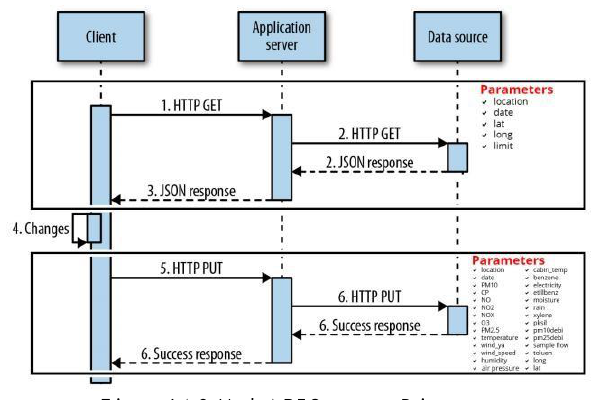
Figure 4.AQ Web API Sequence